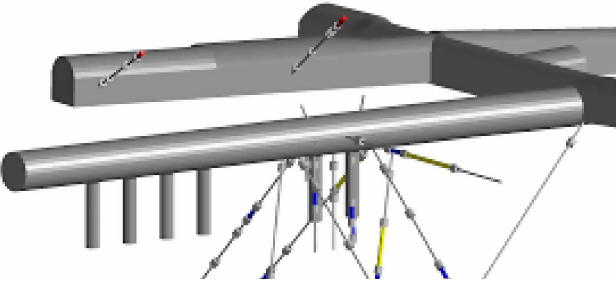
Fig. 12. The Prototype Repository is a full-scale field experi- ment in crystalline rock at a depth of 450 m in the ¨Asp¨o Hard Rock Laboratory (SKB).